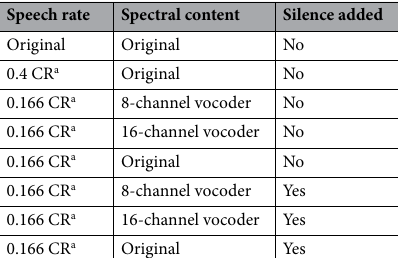
Speech rate Spectral